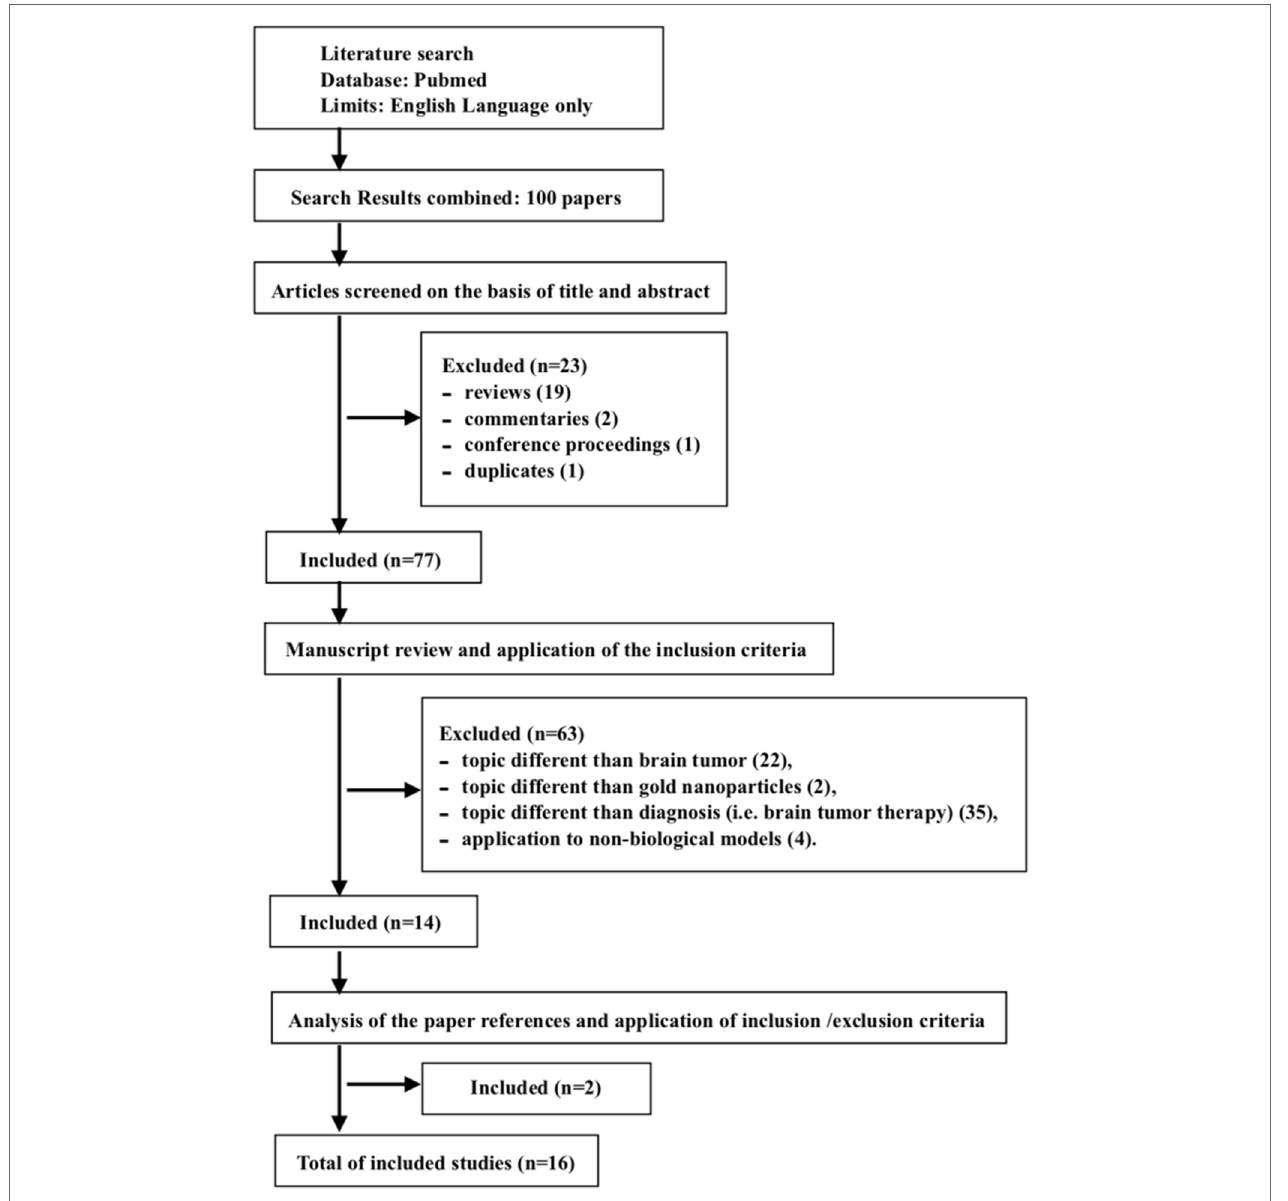
FiGURe 1 | Flow-diagram of study selection, according to PRISMA criteria